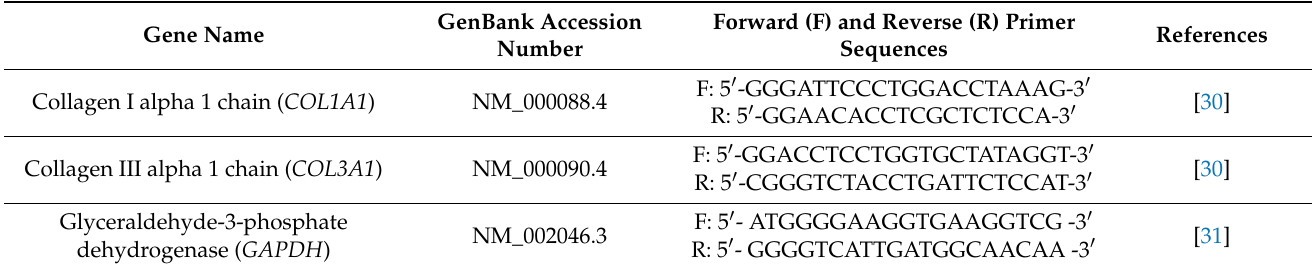
Table 2. Sequences of primers used for the quantitative reverse transcriptase-polymerase chain reaction